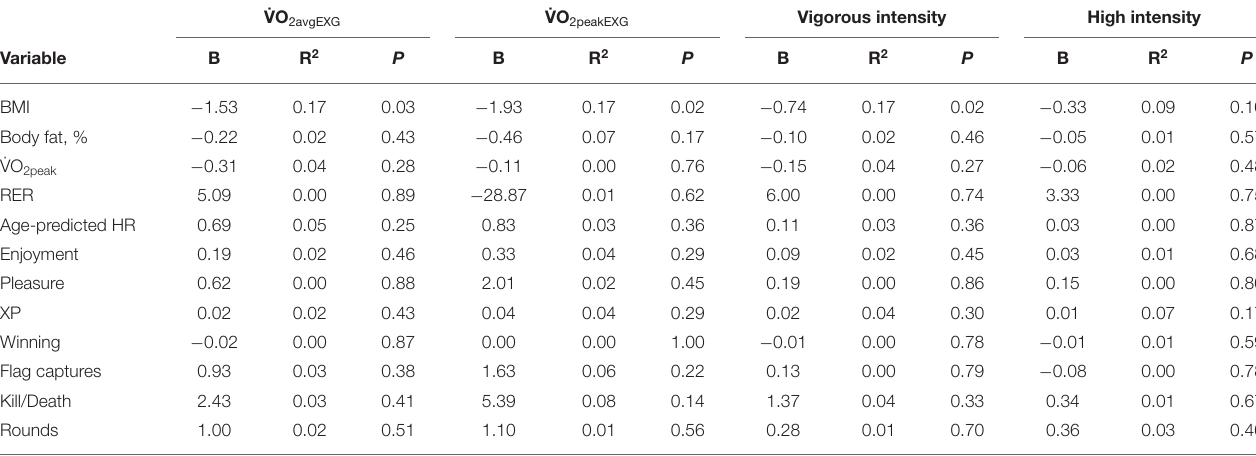
TABLE 3 | Regression analyses for average oxygen uptake during exergaming ( ˙ VO2 avgEXG ), peak oxygen uptake during exergaming ( ˙ VO 2peakEXG ), minutes at or above vigorous exercise intensity (vigorous intensity), and minutes with high intensity (high